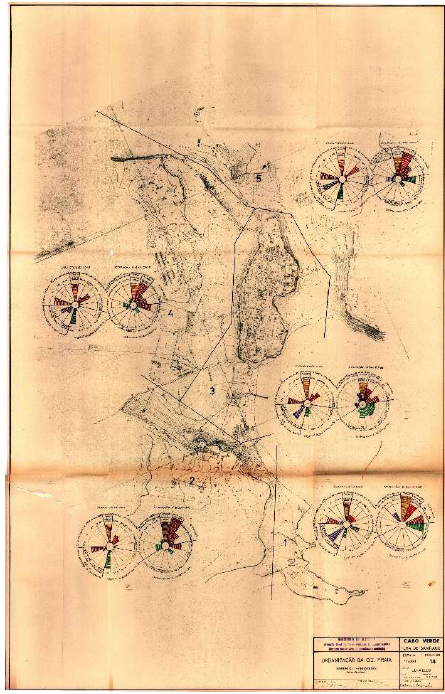
Figure 7. Maria Emília Caria. “City of Praia Urban Development Plan, Santiago Island, Cape Verde, Figure 7. Maria Em í lia Caria. “City of Praia Urban Development Plan, Santiago Island, Cape